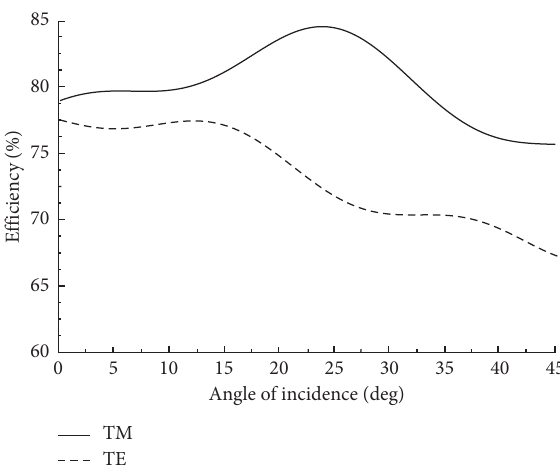
Int ) in relation to